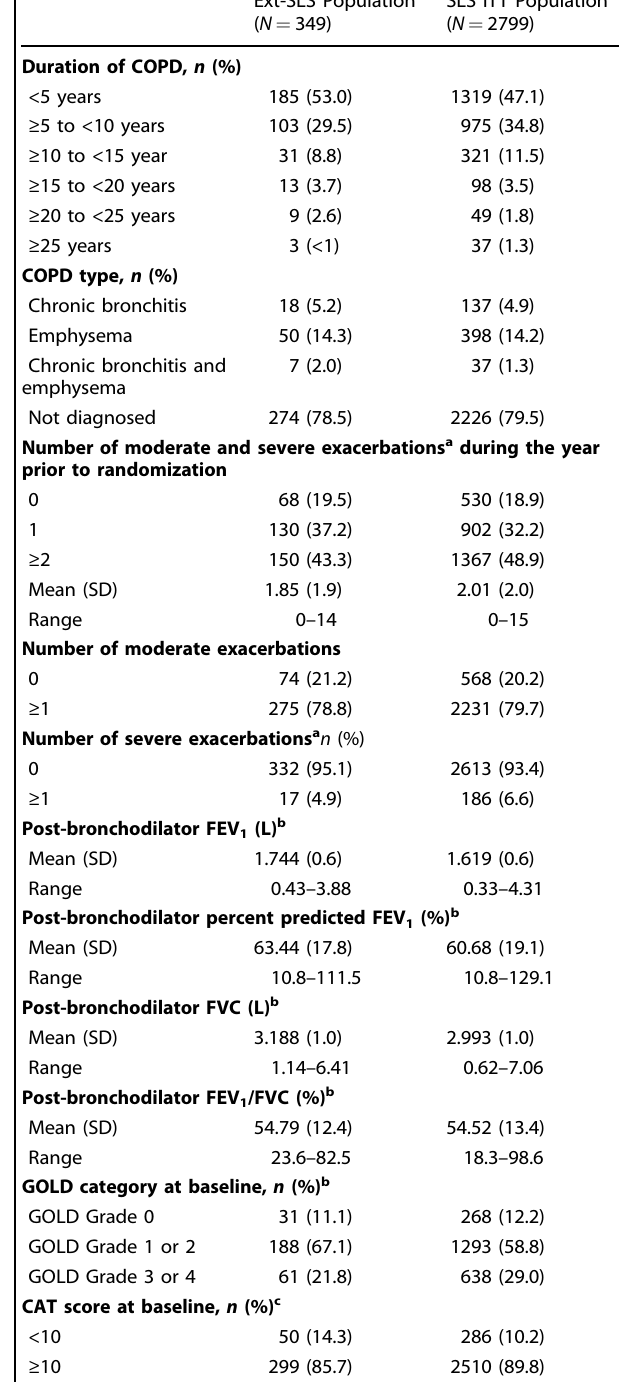
Table 4. COPD disease characteristics in the Ext-SLS cohort and SLS ITT populations, captured at the entry to the SLS. Ext-SLS Population ( N =